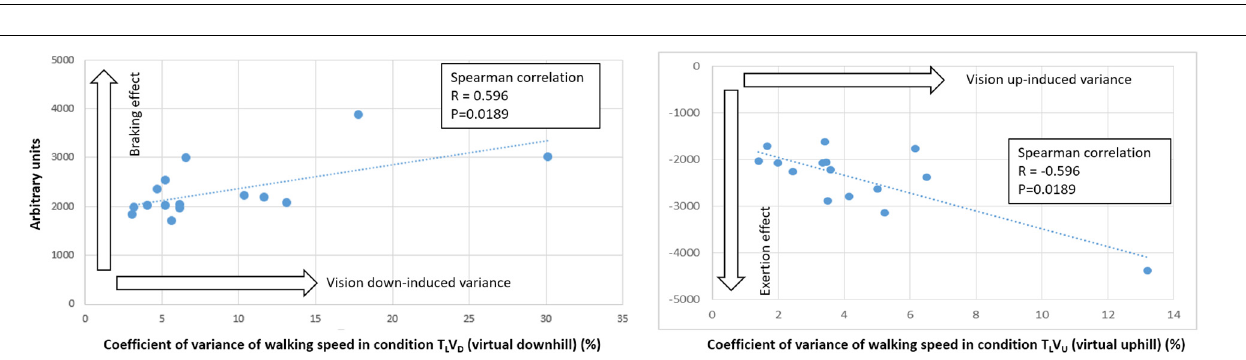
( Figure 1B ). To evaluate our hypotheses regarding the effect of incongruence on walking adaptation, we first characterized the effect on walking speed of a congruent transition from level walking. Walking speed remained largely constant during level walking ( P = 0.471 in the comparison of walking speed 20 after – no- transition with steady-state velocity: ssv) ( Figure 2 , middle